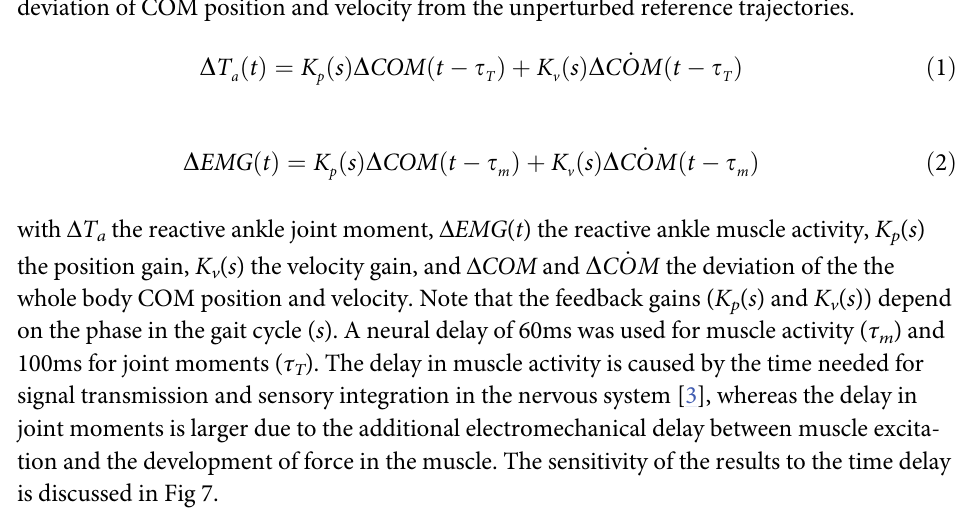
Fig 1. Overview datasets and hypotheses. We answered three research questions related to sensorimotor transformations underlying balance control by combining four previously published datasets with motion capture data of unperturbed and perturbed standing and walking. We used data of surface perturbation in standing [26] and walking [9, 10, 27] to evaluate if the ankle strategy is related to deviations in COM kinematics. Balance was perturbed during walking using both discrete and continuous surface perturbations [10, 27] and discrete pelvis push perturbations [9]. The potential modulation of feedback gains during the gait cycle was evaluated using a dataset with continuous surface perturbations during walking [27] and a dataset with perturbations applied at discrete instances of the gait cycle [10]. Finally, we used data with discrete surface translations in standing and walking to evaluate if altered sensorimotor transformations can explain the adjusted kinematic strategies to control balance observed in older adults. In all these experiments combined, joint kinematics and ground reaction forces were measured in 41 young subjects in total.